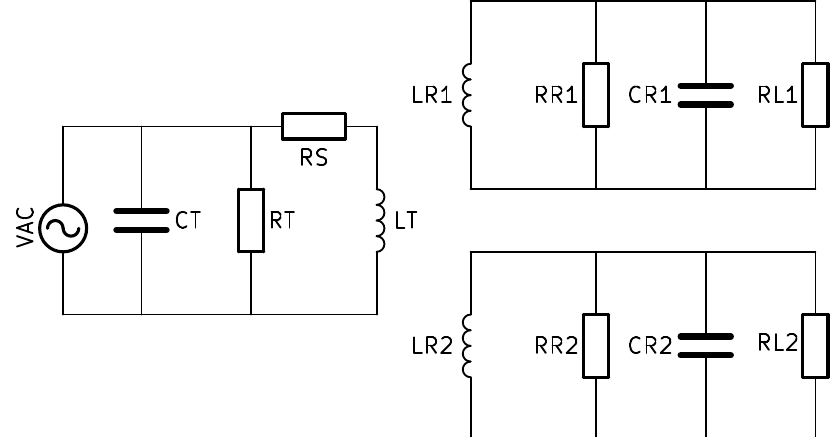
Figure 2. The equivalent circuit diagram of the proposed